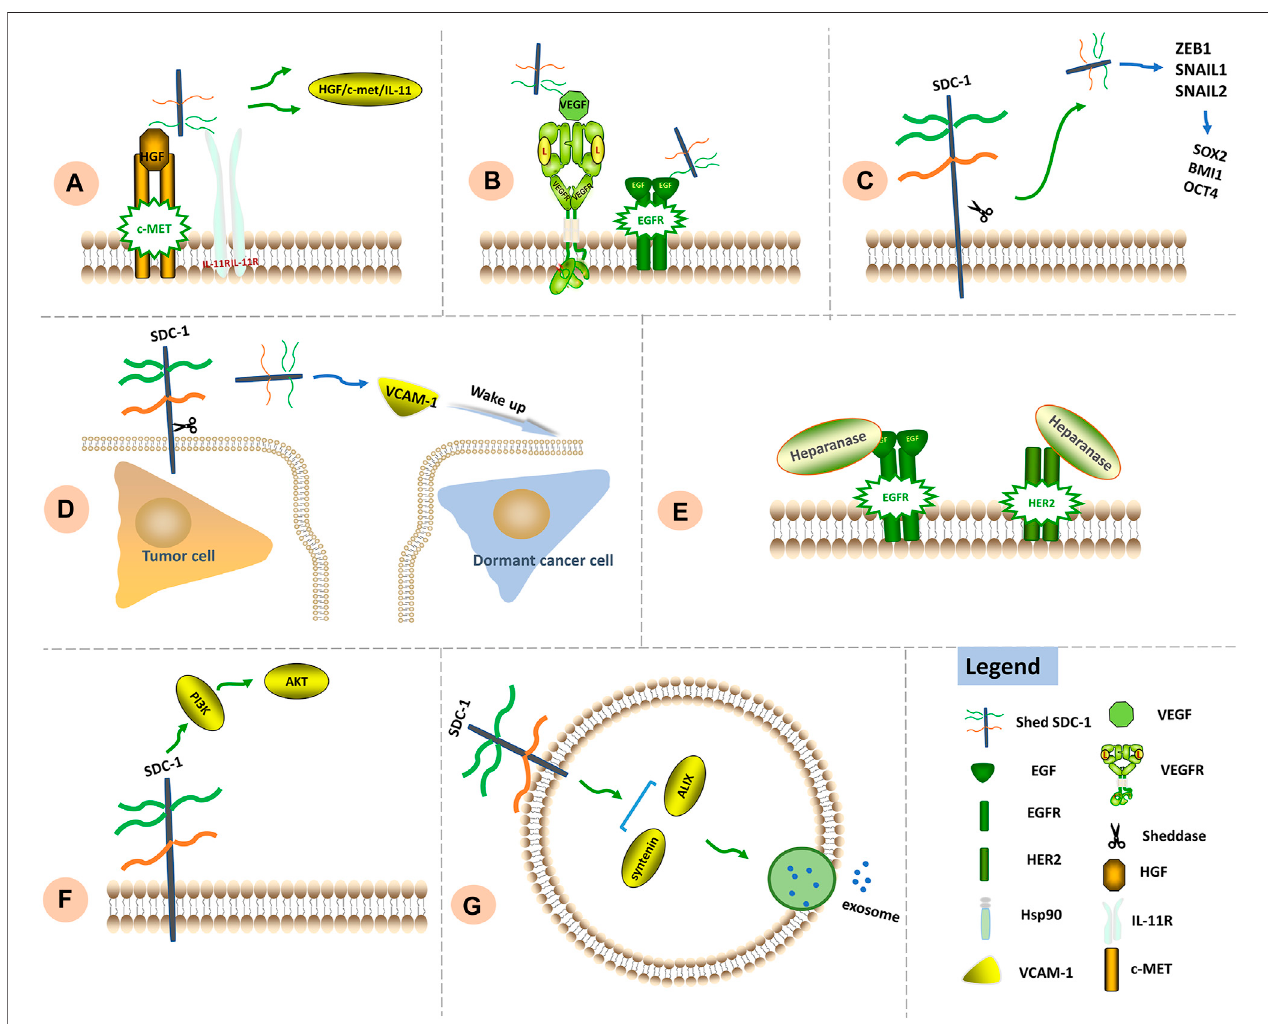
FIGURE 3 | Signaling functions of SDC-1 in chemoresistance. (A) Chemotherapy leads to SDC-1 shedding. Shed SDC-1 binds HGF/c-Met/IL-11, exacerbating drug resistance. (B) Shed SDC-1 promotes VEGF signaling. The HS chains of shed and full-length SDC-1 compete to bind downstream EGFR, thereby increasing the rateofangiogenesisaswellaschemoresistance. (C) ShedSDC-1upregulatesEMT-TFsincludingZEB1,Snail1andSnail2toinduceexpressionofthestemnessfactors SOX2, BMI1 and OCT4, thus facilitating chemoresistance. (D) Shed SDC-1 increases VCAM-1 expression and subsequently promotes growth of otherwise dormant cancer cells, thus facilitating disease relapse and metastasis. (E) Increased heparanase activity contributes to lapatinib resistance via regulation of HER2 and EGFR signaling. (F) Themodulation ofPI3K/AKTsignaling bySDC-1hasbeen associated withchemoresistance. (G) TheSDC-1cytoplasmicregionbindssynteninand ALIX to generate a complex that allows intraluminal vesicles to emerge within endosomal membranes, thus facilitating exosome formation.